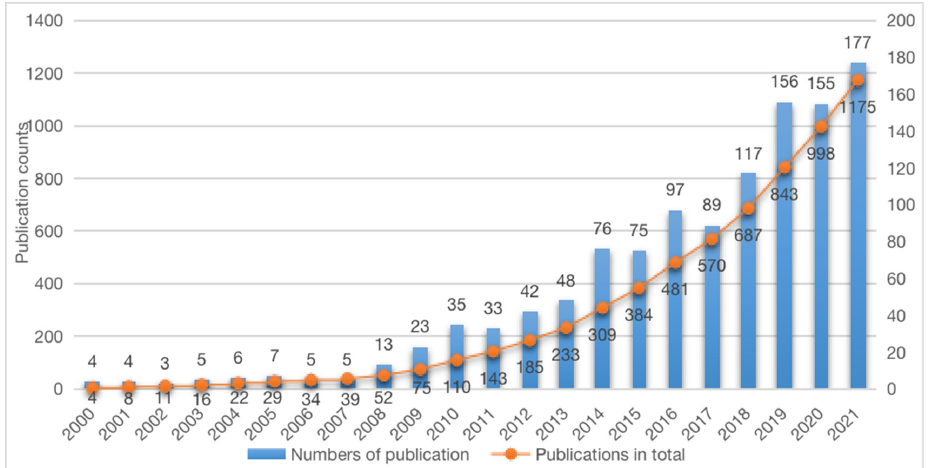
Figure 2. Chronological distribution of the number of climate change science communication research papers from 2000 to 2021.